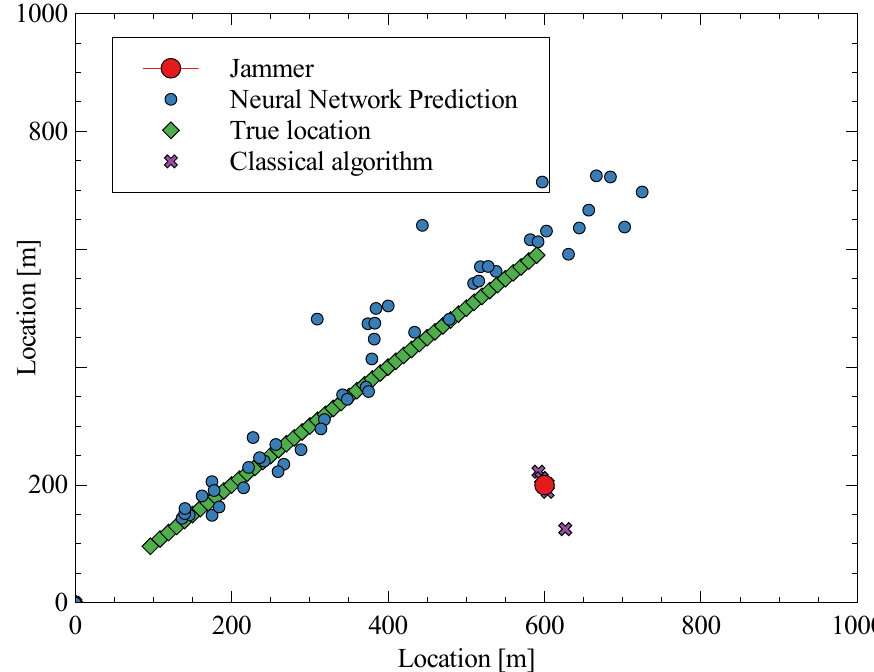
Figure 13. Linear trajectory of the target- green was generated. The jammer was located at [600, 200] m. The neural network predictions are blue. The classical algorithm [7] is violet. It demonstrated confusion about the estimation of the target position. The classical algorithm was evaluated with similar quantities as the neural network approach. However, some violet crosses overlap due to a limited number of